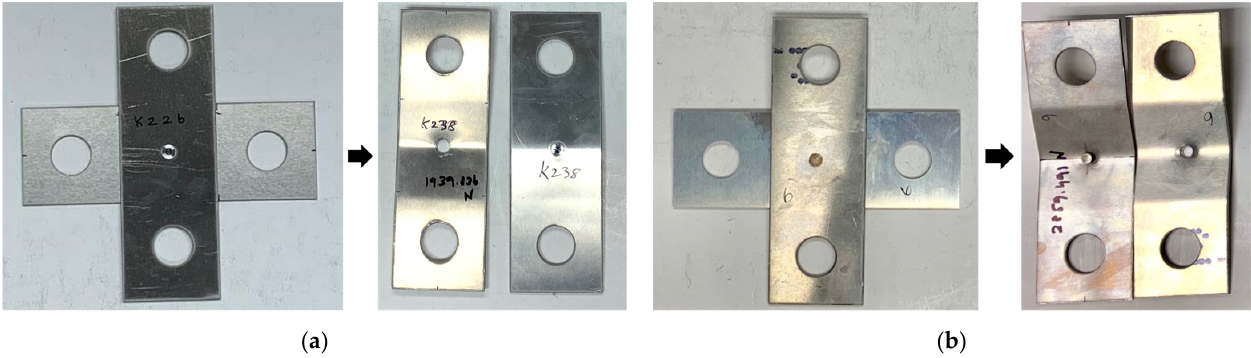
Figure 10. Cross coupons before and after static cross-tension load tests: ( a ) RFSSW cross coupon ( left ) and nugget pullout failure ( right ); ( b ) rivet cross coupon ( left ) and rivet pullout failure ( right ). The image of the nugget pullout failure shows the external surface of the stiffener piece and the faying surface of the skin piece. The image of the rivet pullout failure shows the external surface of the skin piece and the external surface of the stiffener pieces.